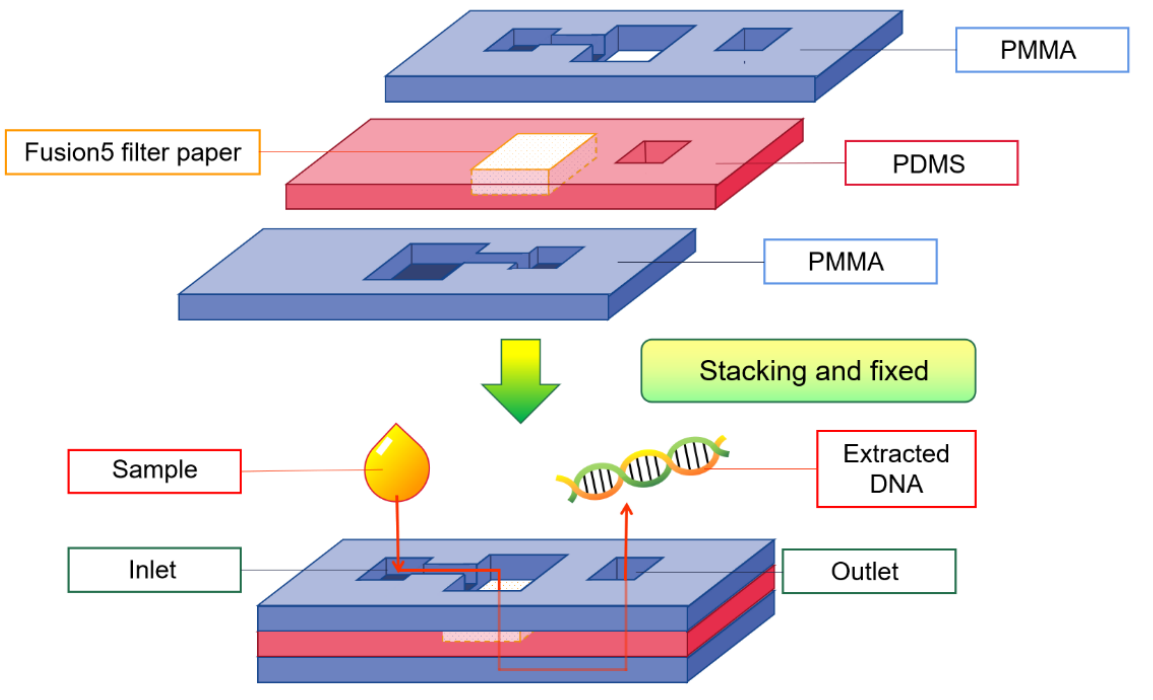
Figure 6. DNA extraction device designed by Gan et al. [99].